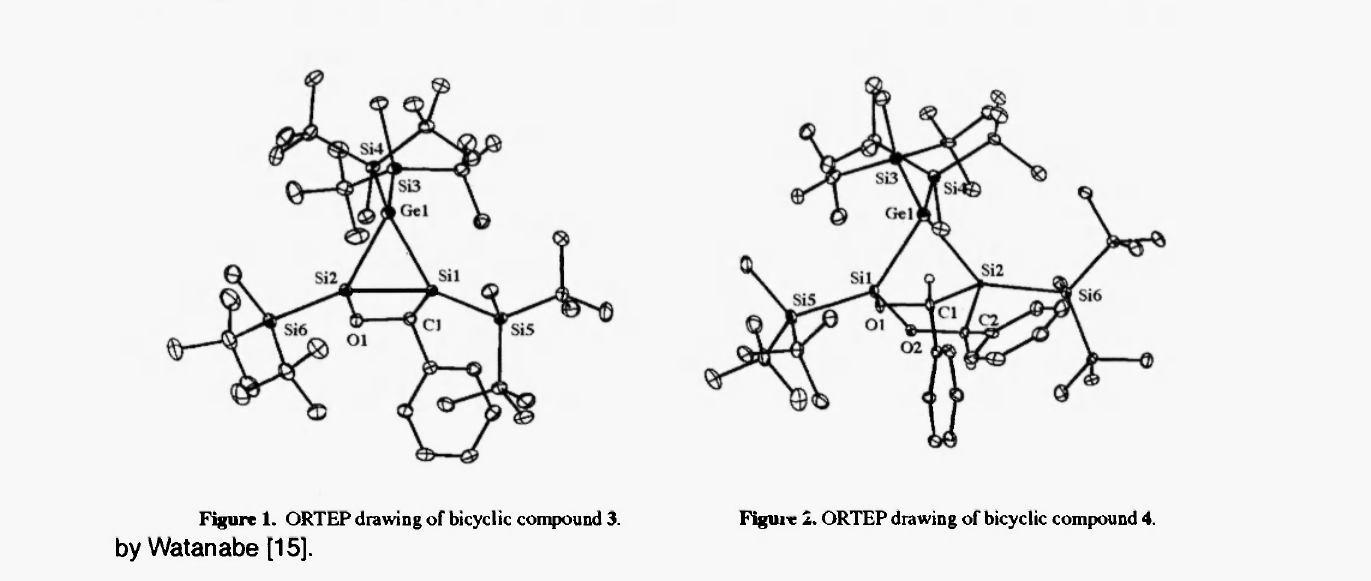
Figure 1. ORTEP drawing of bicyclic compound 3. Figure 2. ORTEP drawing of bicyclic compound